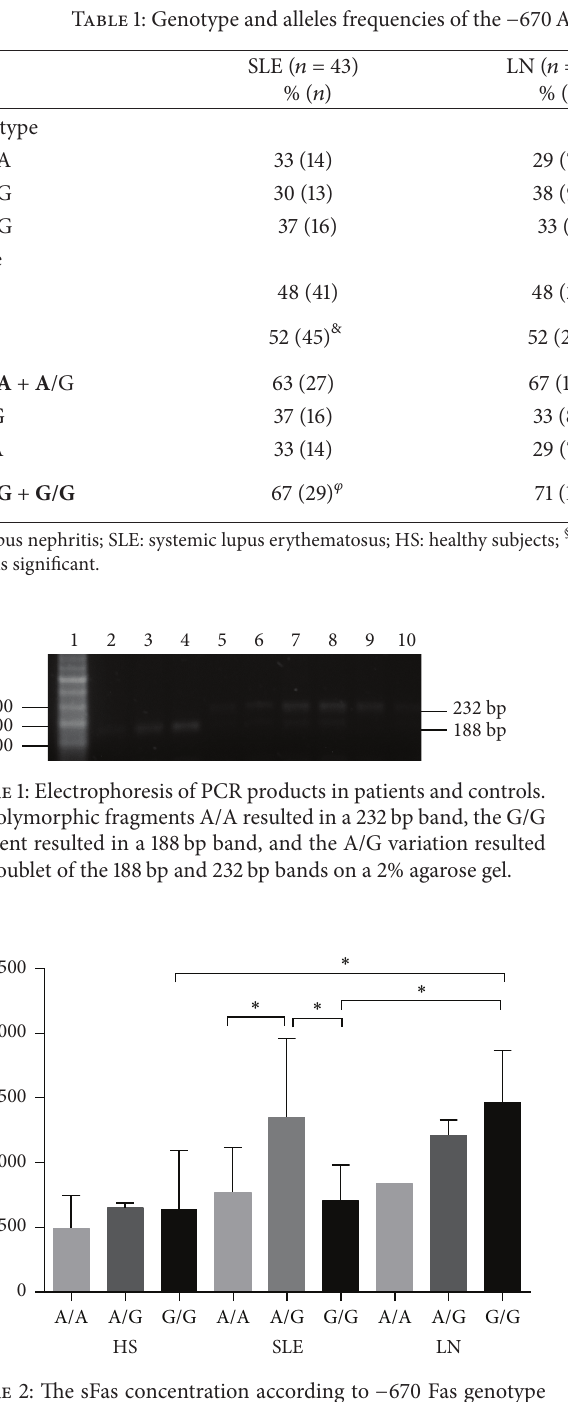
Figure 2: The sFas concentration according to − 670 Fas genotype in LN and SLE patients and HS. The concentration of sFas was increased in LN patients with the G/G genotype and was signifi- cantly different from patients with SLE. ∗ 𝑃 < 0.05 .